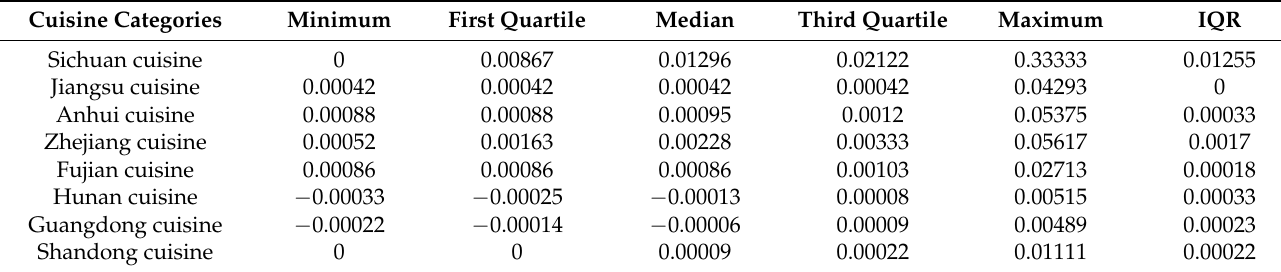
Figure 6. Box-plots of eight cuisines in different regions. ( a ) box-plot with high standardized values, ( b ) box-plot with low standardized values. Table 2. Characteristic variables of the box-plot of eight famous Chinese